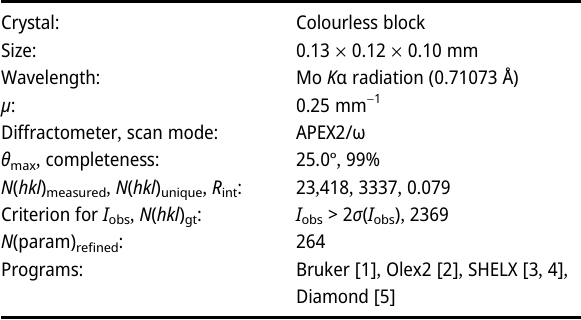
Table 1 contains crystallographic data and Table 2 contains